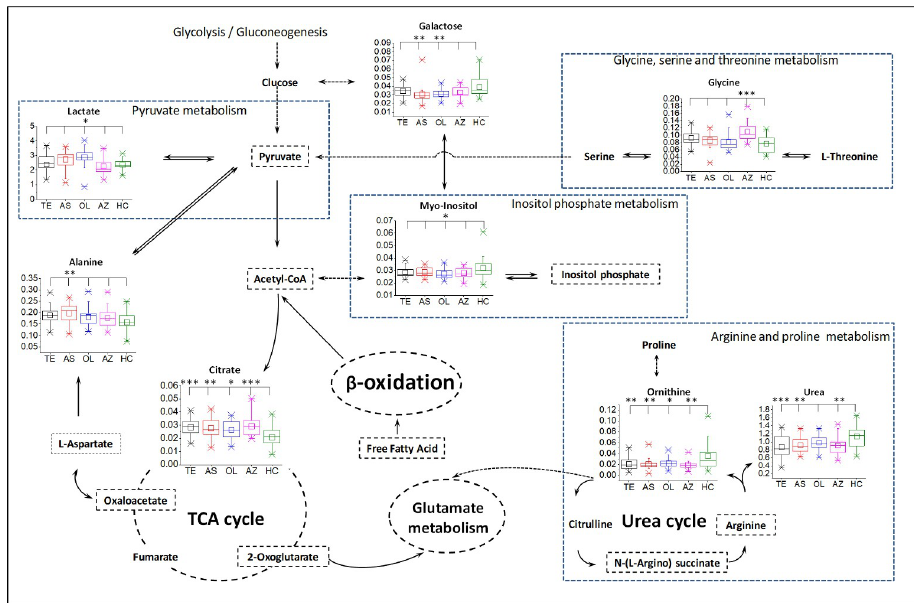
Fig 5. Metabolic network of the significantly changed metabolites. All the p-values between SA subgroups and HC were calculated using ANOVA with Dunnett post hoc. � , p-value < 0.05; �� , p-value < 0.01; ��� , p-value < 0.001. Nonsignificantly changed metabolites are shown only by name, and the names with a dashed rectangle represent the undetected metabolites or metabolisms. Dashed arrows indicated multistep reactions. Single and double bidirectional arrows indicate reactions with the same conditions and different conditions, respectively. The dashed circle denoted the cycle of reaction.